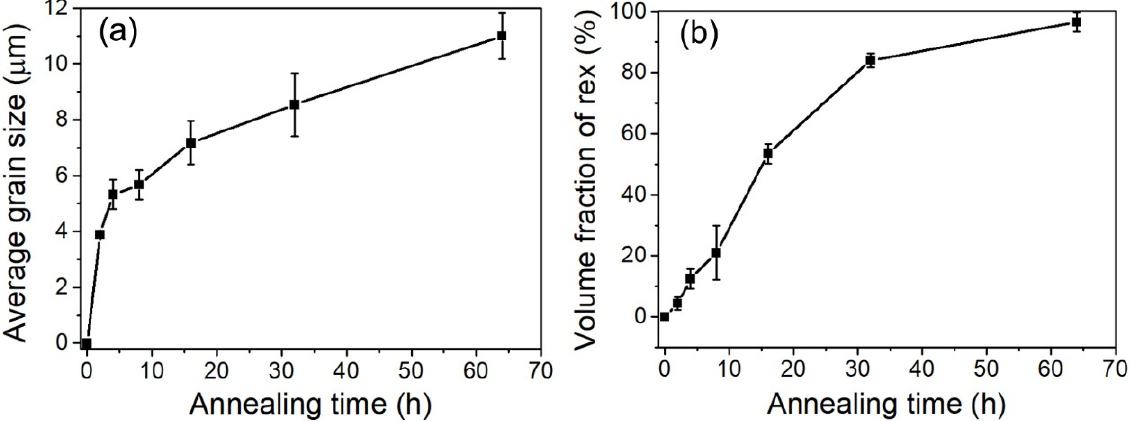
Figure 3. Changes in the average Rex grain size ( a ) and volume fraction of the Rex grain ( b ) of the cold-rolled IF steel during annealing at 600 °C for varying time periods.